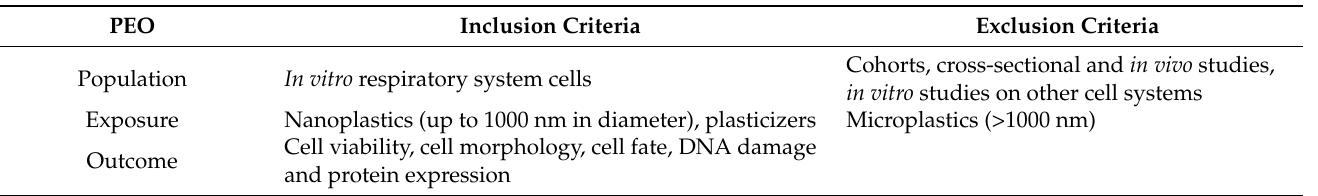
Table 1. PEO criteria for inclusion and exclusion in the systematic